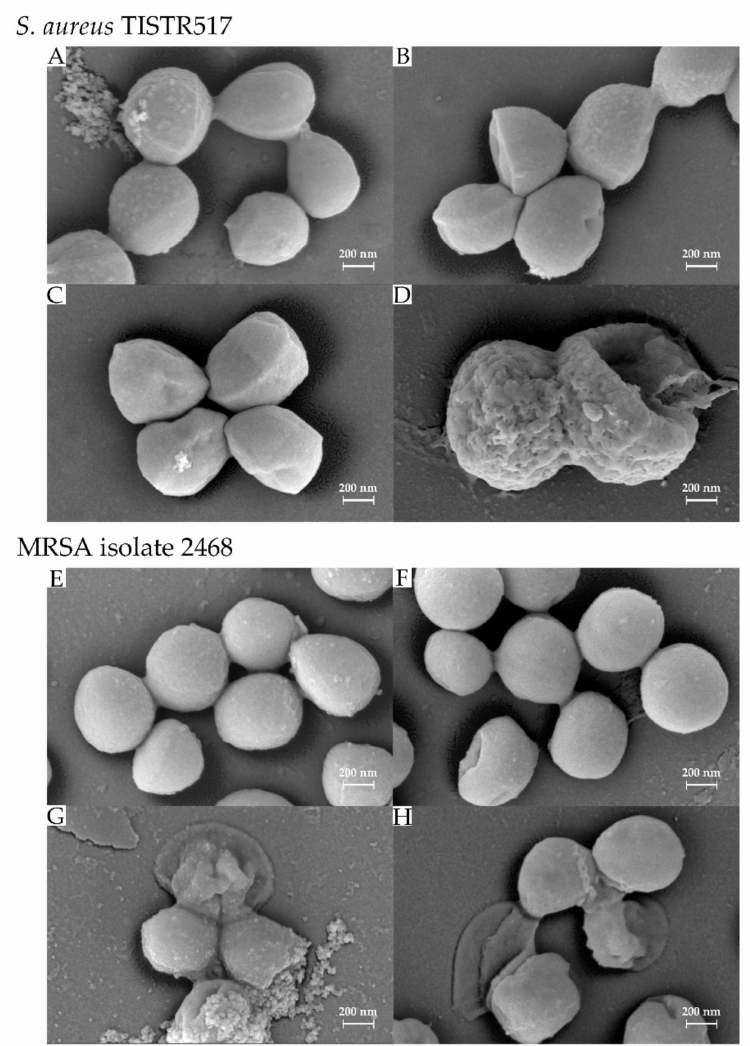
Figure 6. Scanning electron microscope of bacterial cells treated with the purified substance. ( A ) The untreated S. aureus TISTR 517 and ( B – D ) the effect of an antimicrobial substance on S. aureus TISTR 517 for 1, 3, and 6 h, respectively. ( E ) The untreated MRSA isolate 2468 and ( F – H ) the effect of an antimicrobial substance on MRSA isolate 2468 for 1, 3, and 6 h, respectively. The cells were captured at a magnification of 50,000 ×